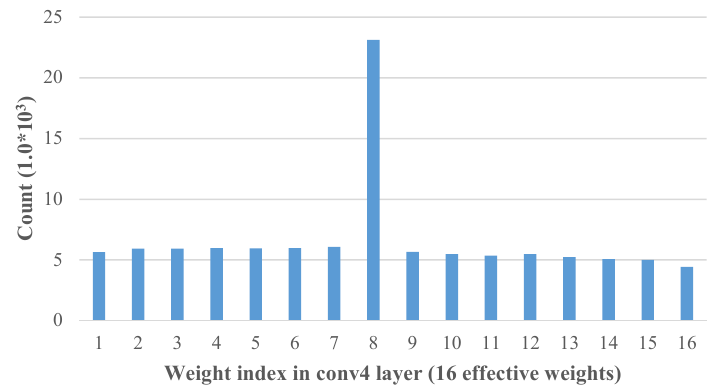
Figure 6. Distribution of cluster indexes in conv4